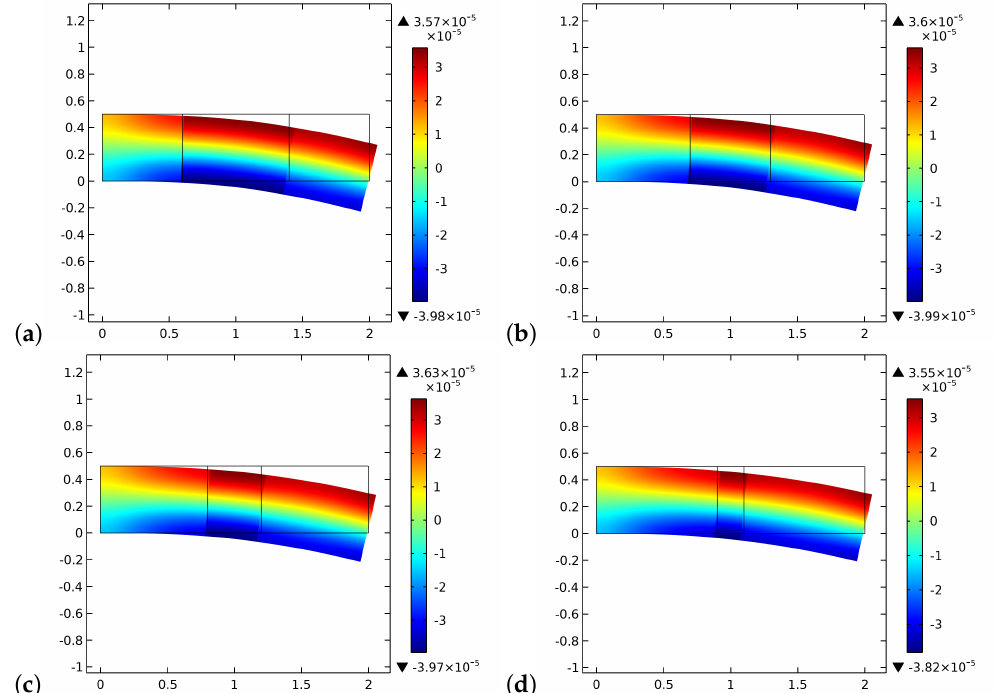
Figure 6. The distribution of ζ at the beginning of the time of simulation for different substitute lengths of the graft: ( a ) 0.8 cm. ( b ) 0.6 cm. ( c ) 0.4 cm. ( d ) 0.2